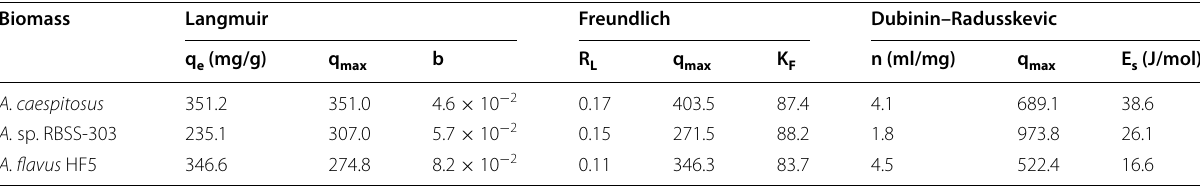
obtained from adsorption isotherms for Pb(II) biosorption max